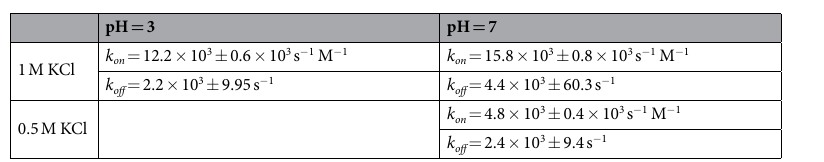
Table 1. The association (k on ) and dissociation (k off ) rate constants characterizing PAMAM-G1 – α -HL interactions at Δ V = + 100 mV, and distinct pH and salt concentrations values used